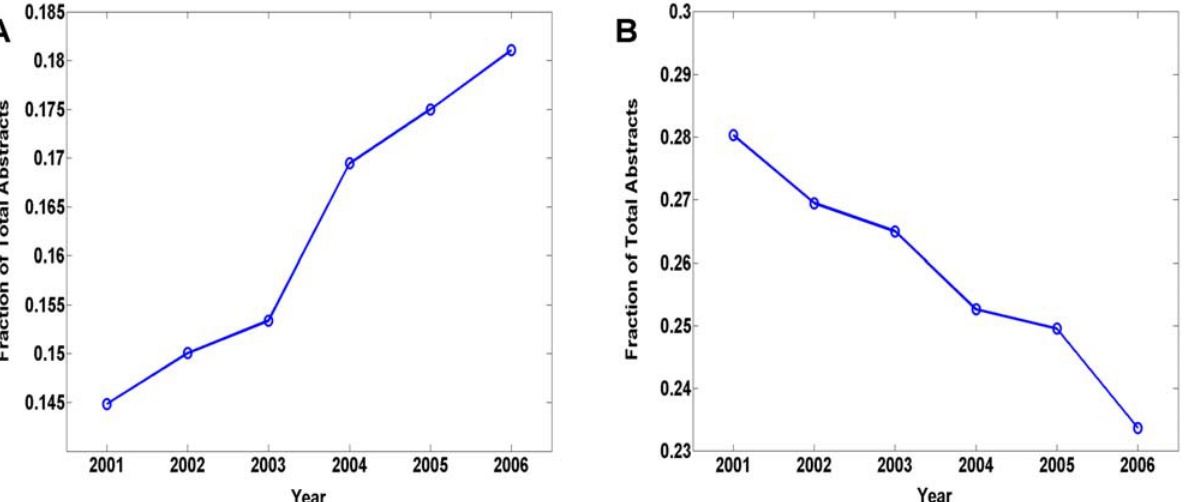
Figure 10. (A) Dynamics of Cluster 9 (‘‘Visual and Motor Systems’’), which shows consistent and strong increase in representation from 2001 to 2006. (B) Dynamics of Cluster 2 (‘‘Cellular Neuroscience’’), which shows steady decrease in representation from 2001 to